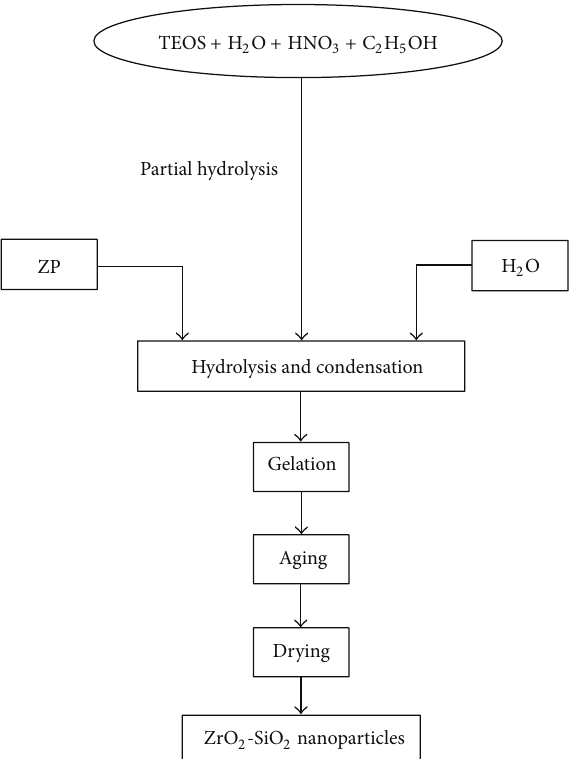
Figure 1: A schematic of ZrO 2 -SiO 2 nanoparticles